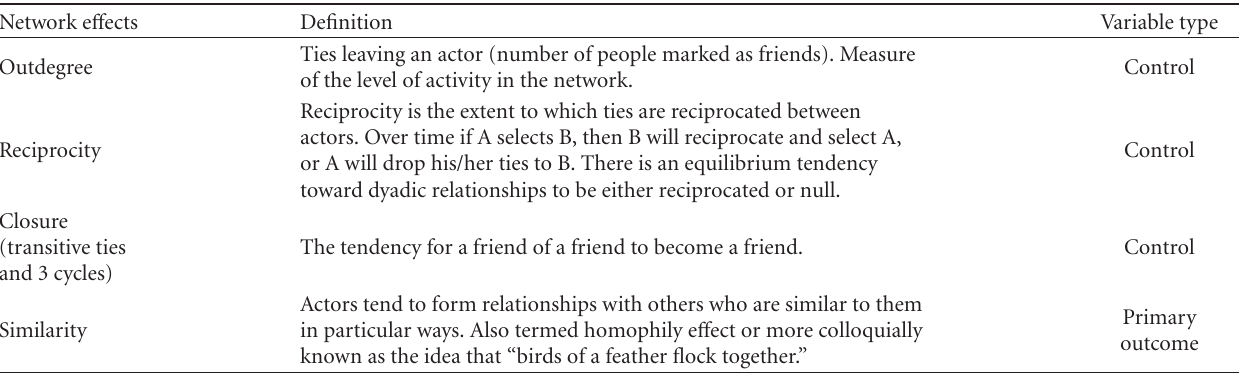
Table 2: Network e ff ects included in the